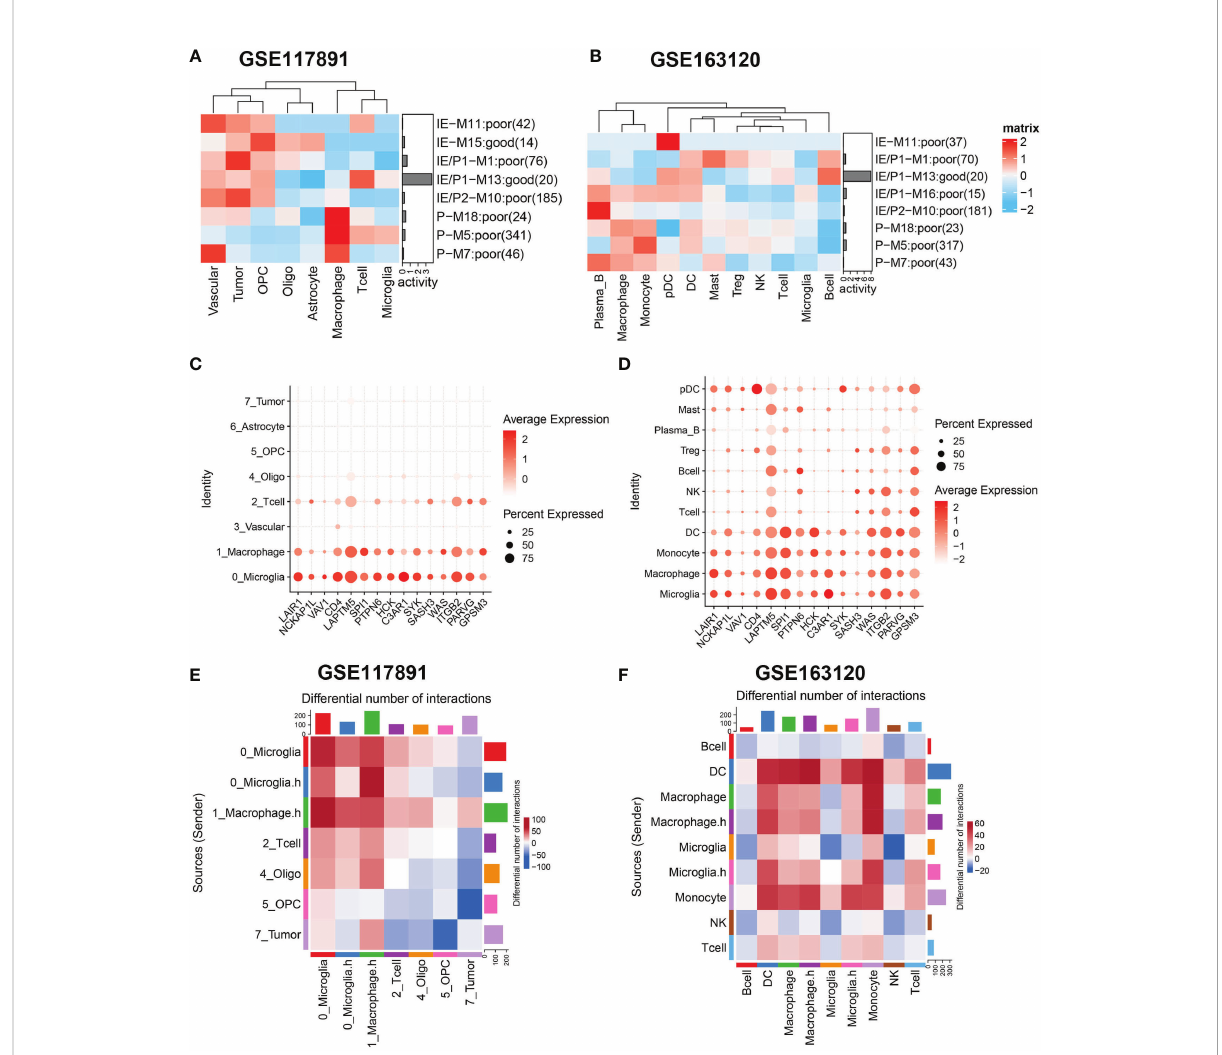
FIGURE 4 Gene sets expression activity and cell-cell interaction in sing-cell RNA-Seq datasets. (A, B) Row scaled gene expression activity of ssMSG across cell types in the GSE117891 and GSE163120 datasets, with the color from blue to red representing the activity score from low to high. Cells were clustered by the activity of these gene sets. (C, D) The expression level of Top15_hub genes across different cell types in two datasets. The larger the size, the larger the percent of expression. The darker the color, the higher the expression. (E) The differential cell – cell interaction weight between the tumor core and peripheral region of GSE117891.Upregulated interactions in tumor core were colored in red, down- regulated in blue. (F) The differential cell – cell interaction weight between recurrent and newly diagnosed samples of GSE163120. Upregulated interactions in recurrent samples were colored in